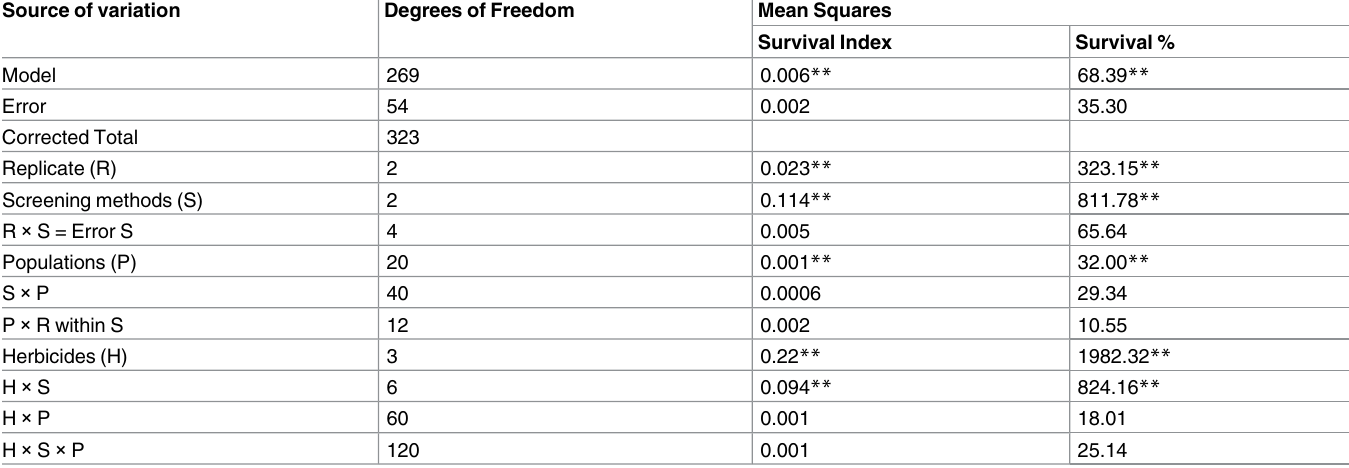
Table 4. Analysis of variancefor survival index and survival % of 21 populations of lentil screenedthrough different methods against different doses of herbicides. Source of